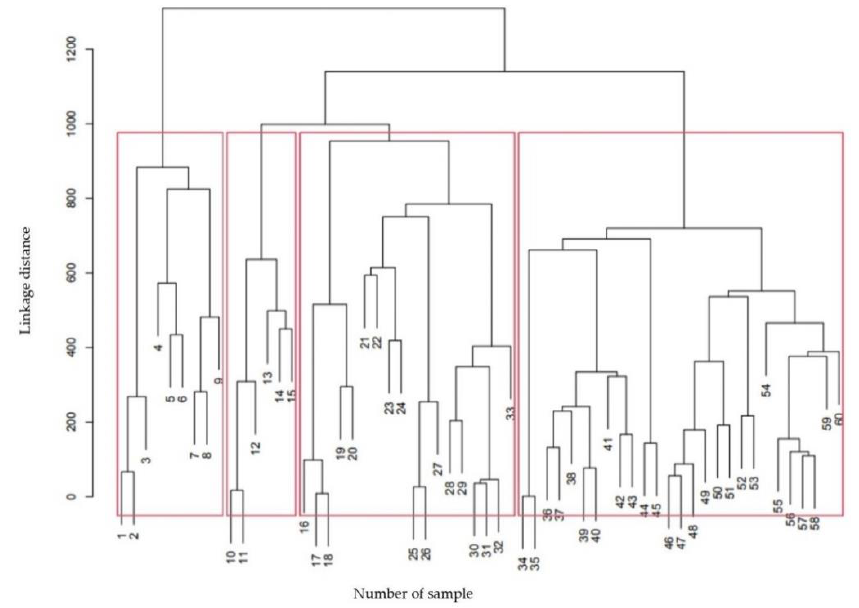
Figure 4. Main types of testate amoeba assemblage along the sampling depth gradient based on the results of constrained cluster analysis (the numbers on the dendrogram correspond to the number of samples in Table S1). Red boxes on the plot mark the main types of testate amoeba assemblages.